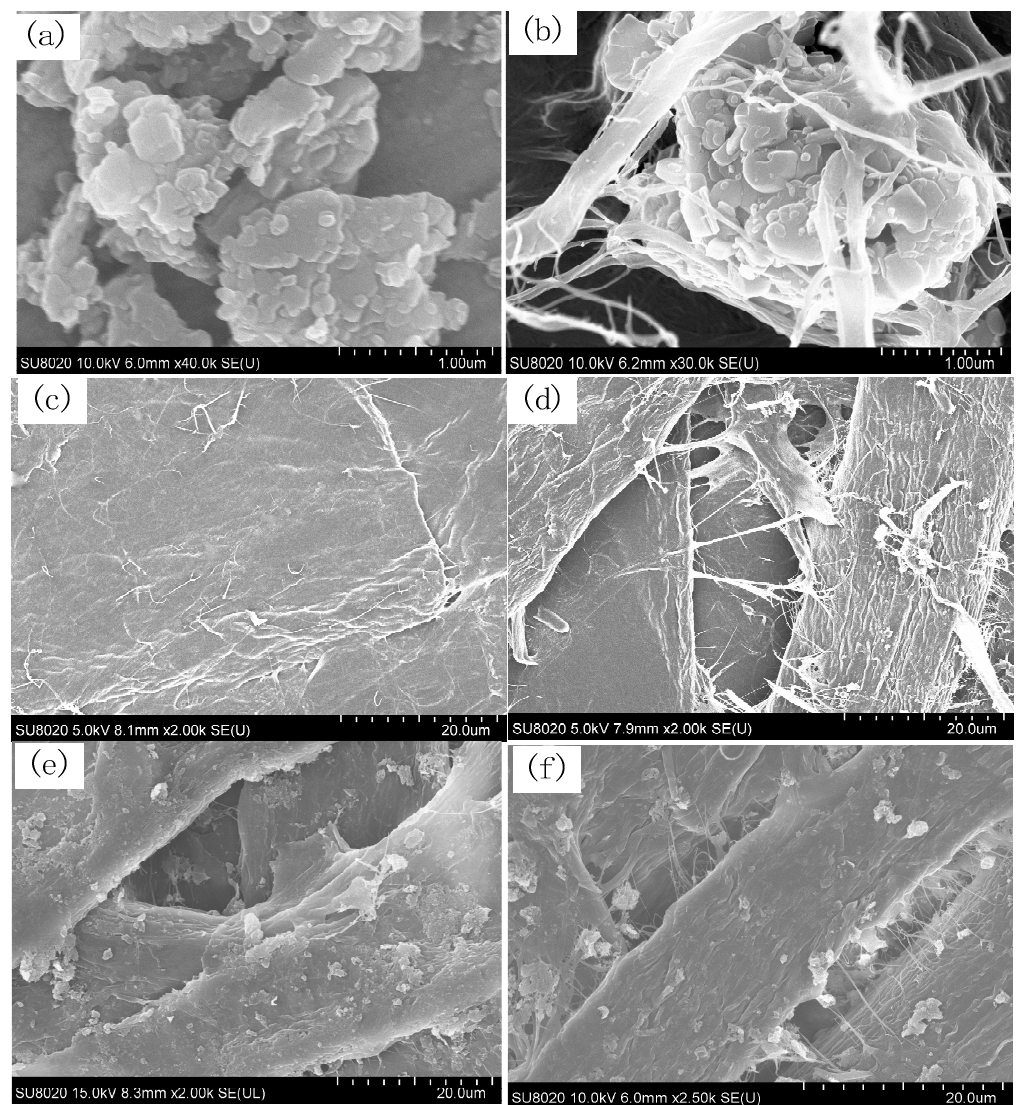
Figure 3. SEM image: ( a ) nano-h-BN sheets, ( b ) CNF-modified nano-h-BN, ( c ) unmodified pressboard, ( d ) CNF-modified pressboard, ( e ) h-BN-modified pressboard, and ( f ) h-BN + CNF-modified pressboard.